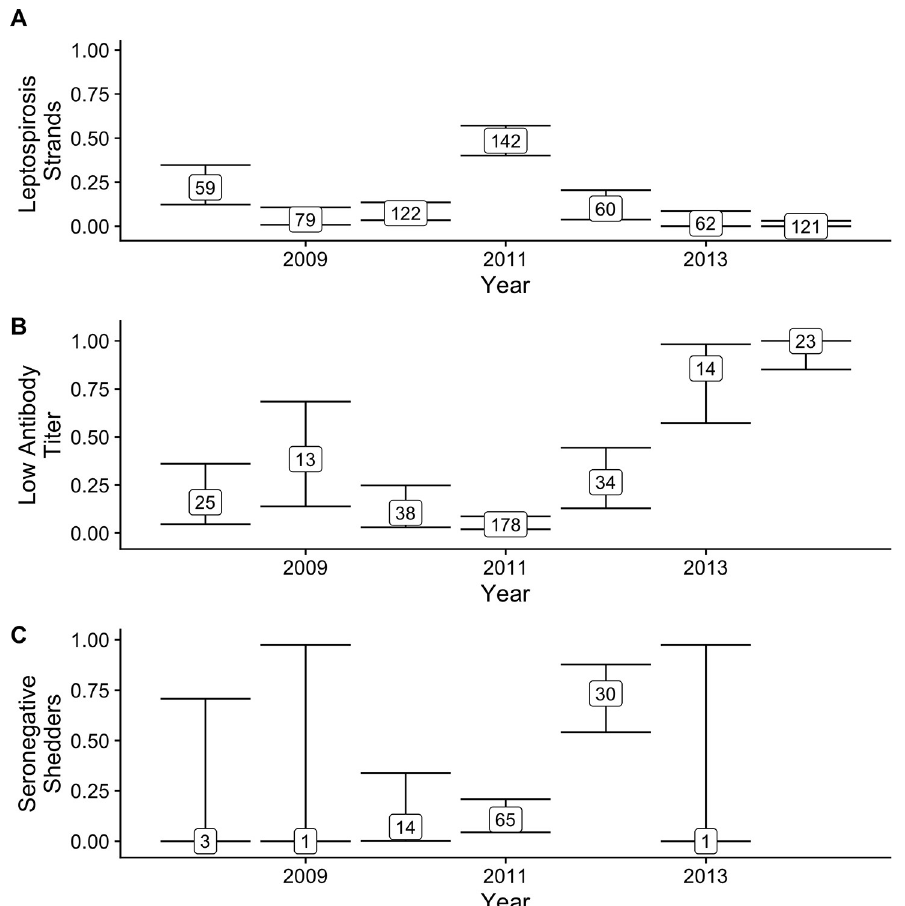
Fig 7. Proportion of stranded animals with leptospirosis (A), proportion of seropositive animals that have low titers (log 2 titer 1–5) by year with 95% CI (B), and proportion of shedding animals that are seronegative by year with 95% CI (C). Total sample size for each proportion is indicated within the box. Only STRAND data included in (A) WILD and STRAND data for (B) and (C). The proportion of leptospirosis strands is highest in the two major outbreak years– 2008 and 2011 –and the proportion of low titer animals increases with each year after the outbreaks. Similarly, the proportion of seronegative shedders increases after the major outbreak in 2011, but then declines to zero by 2013. The single shedder in 2013 had a log 2 antibody titer of 3, no animals were shedding in 2014; therefore a proportion could not be calculated. Few shedders were detected in 2008 and 2009 due to small sample sizes of animals PCR tested for shedding (2008 N = 6, 2009 N = 3, 2010 N = 71, 2011 N = 147, 2012 N = 116, 2013 N = 163, 2014 N = 291).